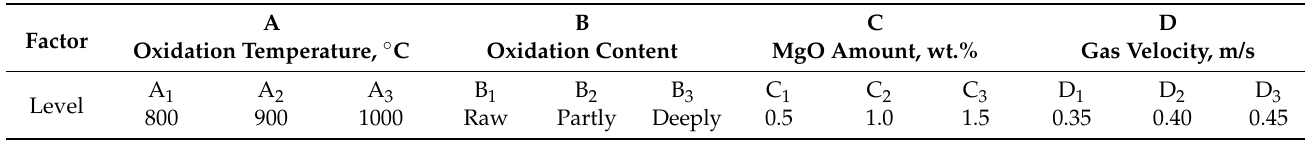
Figure 1. Schematic layout of laboratory fluidized bed reactor [21]: (1) gas system; (2) three-stage electrical furnace; (3) gas distributor; (4) fluidized bed reactor; (5) dust filter; (6) scale; (7) pressure regulator; (8) differential pressure monitor; (9) temperature control; and (10) computer system unit. Table 2. Orthogonal experimental factors and levels.